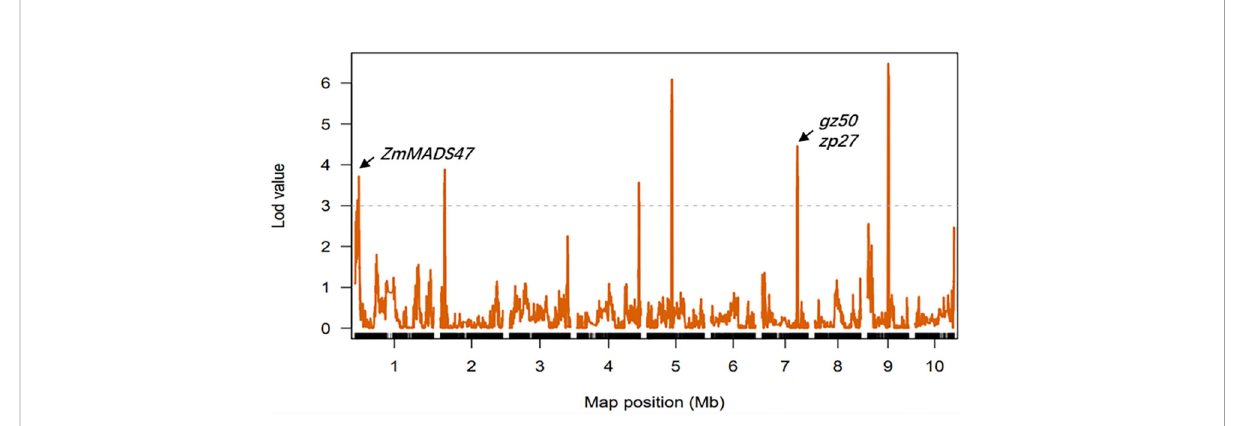
FIGURE 4 Mapping of QTLs for protein on the ten maize chromosomes in three different environments (combined). The curves indicate the physical positions (x-axis) of the bin markers against the LOD scores (y-axis) for QTLs detected on each of the ten chromosomes. The gray dashed lines represent the LOD threshold.